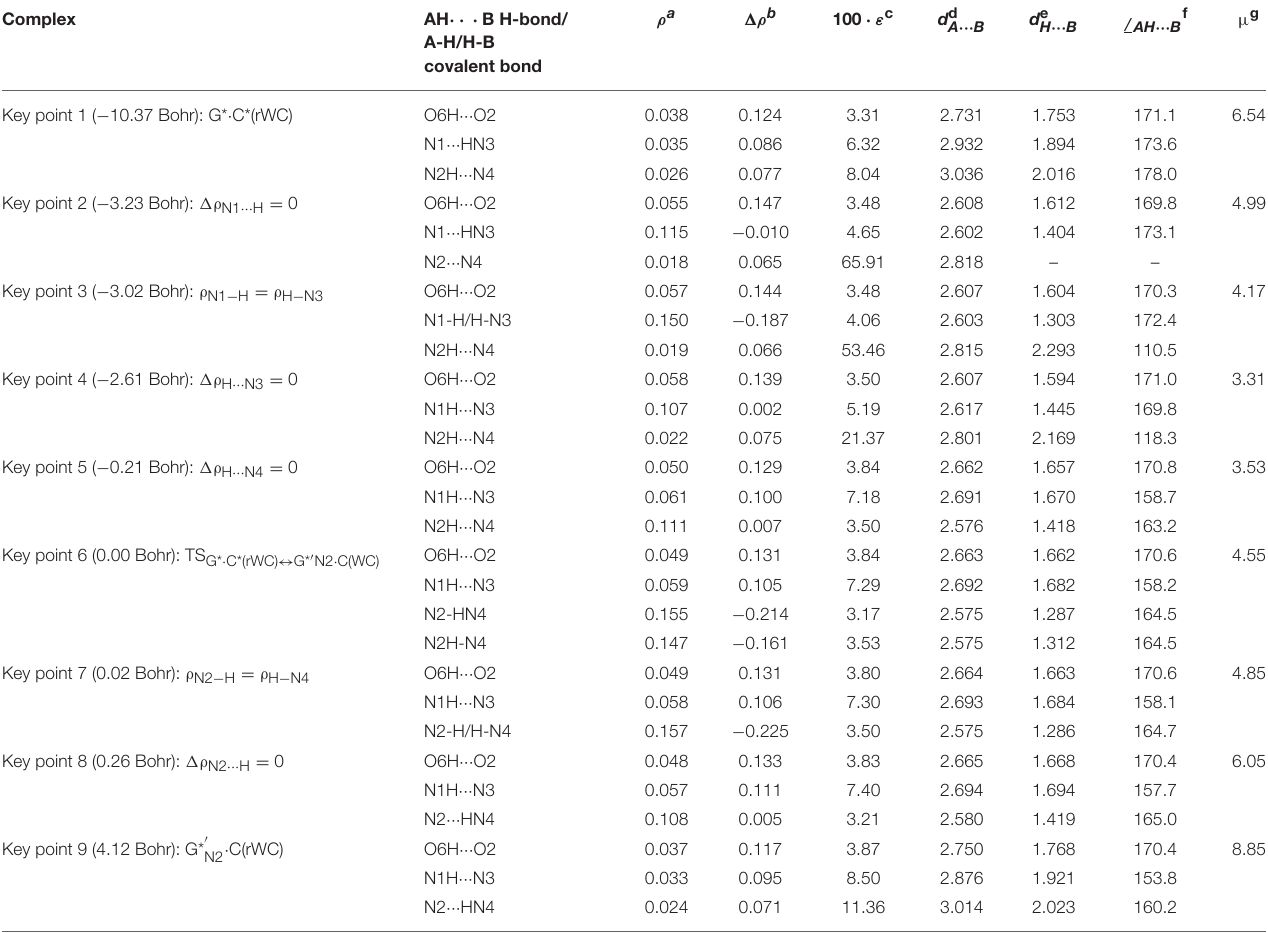
TABLE 5 | Electron-topological and structural characteristics of the specific intermolecular bonds revealed in the 9 key points and the polarity of the latters along the IRC C(rWC) tautomerisation obtained at the B3LYP/6-311 of the III. G* C*(rWC) G* ′ N2 · · ↔